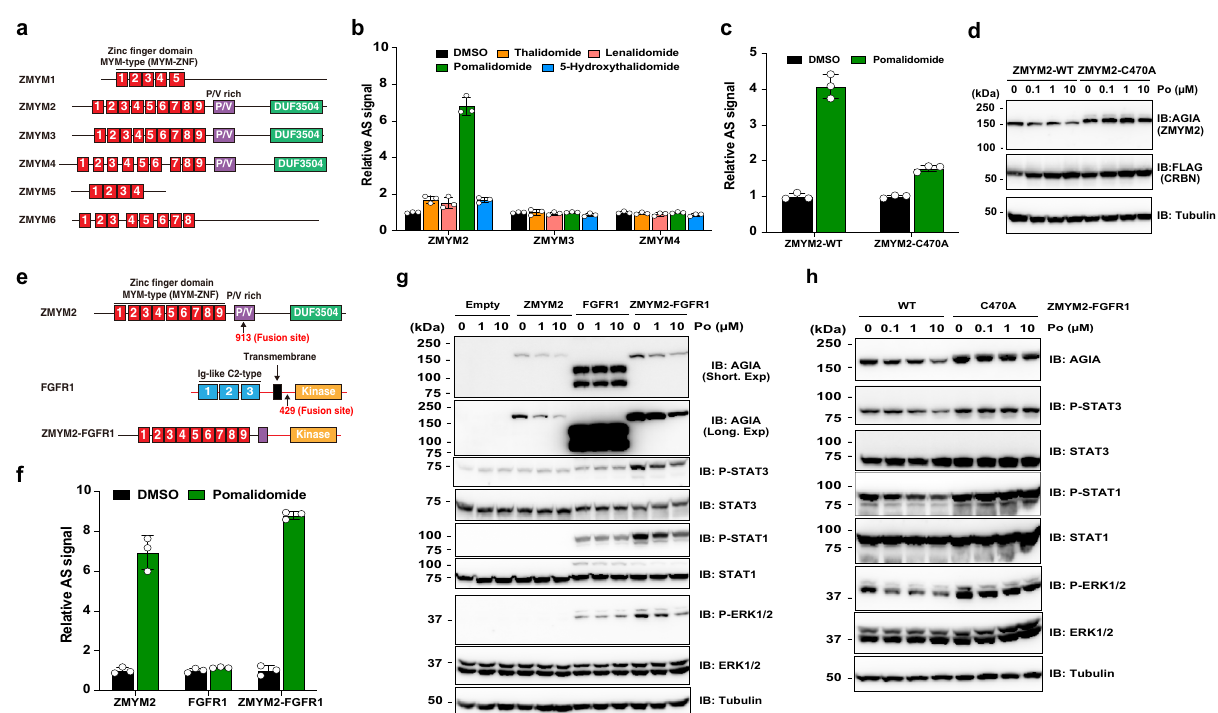
Fig. 6 ZMYM2-FGFR1 fusion protein is degraded by pomalidomide. a Schematic diagram of ZMYM family proteins. b In vitro interaction assay between CRBN and ZMYM2, ZMYM3 or ZMYM4. The interaction between bls-CRBN and FLAG-GST-ZMYM2, -ZMYM3 or -ZMYM4 in the presence of DMSO or 20 µ M thalidomide (Th), lenalidomide (Le), pomalidomide (Po) or 5-hydroxythalidomide (5HT) was analysed using the AlphaScreen-based biochemical assay. All relative AlphaScreen (AS) signals were expressed as a luminescence signal relative to that of DMSO. Error bars denote the standard deviation (independent experiments; n = 3). c In vitro interaction assay between CRBN and ZMYM2-WT or ZMYM2-C470A. The interaction between bls-CRBN and FLAG-GST-ZMYM2-WT or -C470A in the presence of DMSO or 20 µ M pomalidomide (Po) was analysed using the AlphaScreen-based biochemical assay. All relative AlphaScreen (AS) signals were expressed as a luminescence signal relative to that of DMSO. Error bars denote the standard deviation (independent experiments; n = 3). d Immunoblot analysis of ZMYM2-AGIA protein levels in HEK293T cells expressing ZMYM2-WT- or ZMYM2-C470A- AGIA and FLAG-CRBN treated with DMSO or pomalidomide (Po) for 16 h. The experiments were repeated three times independently with similar results. e Schematic diagram of ZMYM2, FGFR1, ZMYM2-FGFR1 protein. f In vitro interaction assay between CRBN and ZMYM2, FGFR1 or ZMYM2-FGFR1. The interaction between bls-CRBN and FLAG-GST-ZMYM2, -FGFR1 or -ZMYM2-FGFR1 in the presence of DMSO or 20 µ M pomalidomide (Po) was analysed using the AlphaScreen-based biochemical assay. All relative AlphaScreen (AS) signals were expressed as a luminescence signal relative to that of DMSO. Error bars denote the standard deviation (independent experiments; n = 3). g Immunoblot analysis of protein levels in HEK293T cells stably expressing empty, ZMYM2-WT- FGFR1- or ZMYM2-C470A-AGIA treated with DMSO or pomalidomide (Po) every 24 h for 48 h. The experiments were repeated three times independently with similar results. h Immunoblot analysis of protein levels in HEK293T cells stably expressing empty, ZMYM2-FGFR1-WT- AGIA (WT) or ZMYM2-C470A-AGIA (C470A) treated with DMSO or pomalidomide (Po) every 24 h for 48 h. The experiments were repeated three times independently with similar results. Source data are provided as a Source data fi